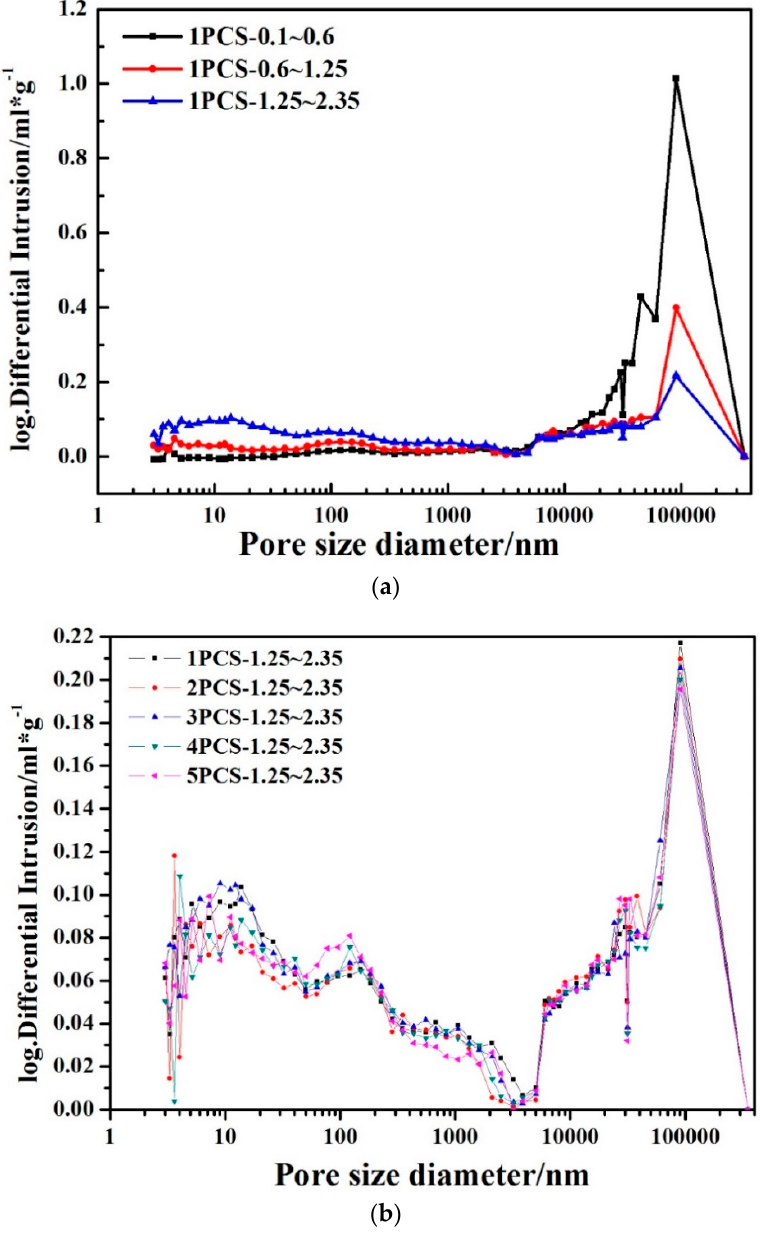
Figure 5. The pore distribution of all PCS samples; ( a ) 1PCS-n, (n = 0.1~0.6, 0.6~1.25, 1.25~2.35 mm); ( b ) mPCS-1.25~2.35, (m = 1, 2, 3, 4, 5 g/L). Table 4. The total porosity and pore volume of all PCS samples.